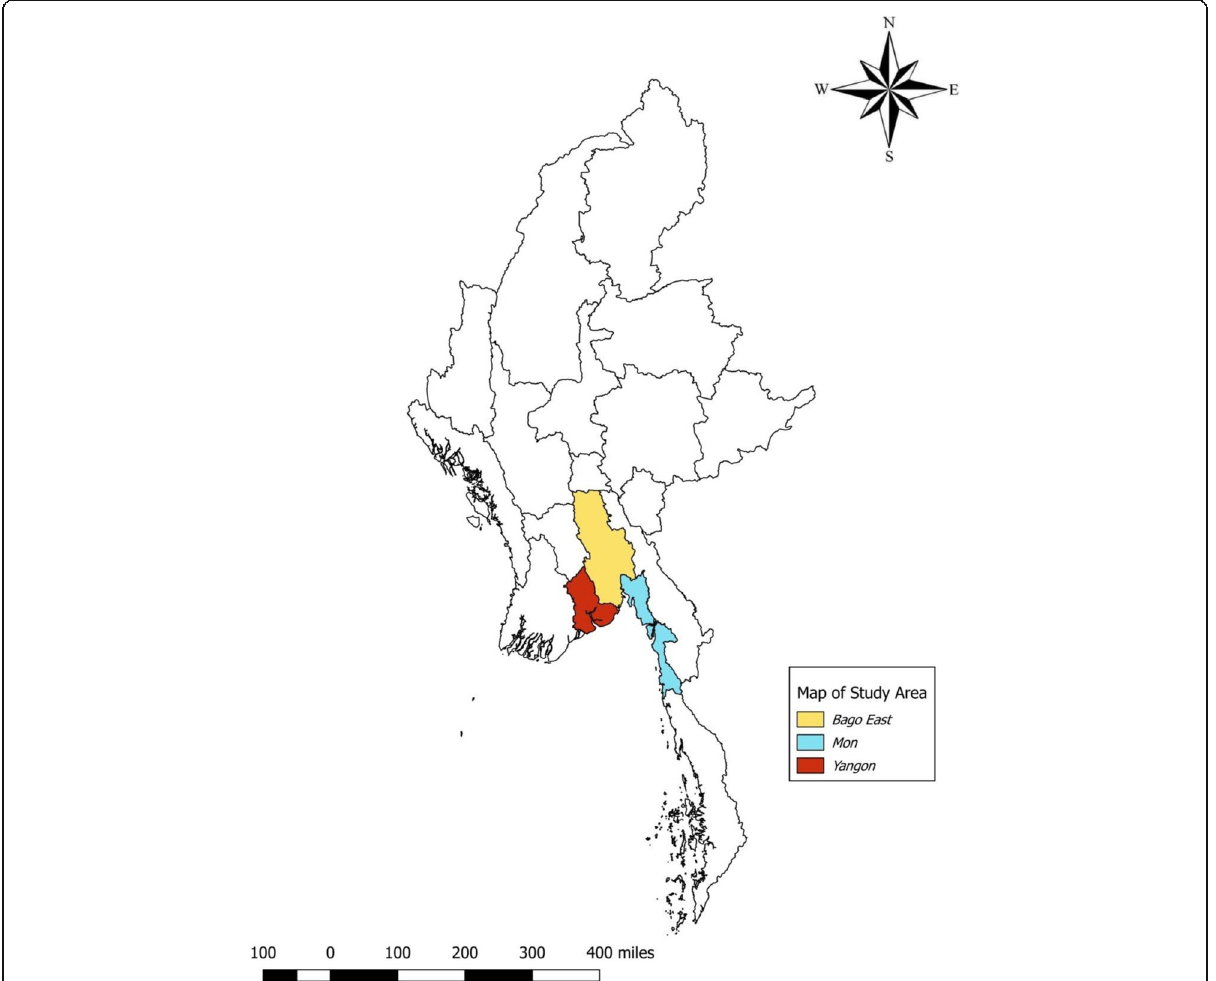
Fig. 1 Map of Myanmar with study areas implemented the malaria surveillance and response strategy,